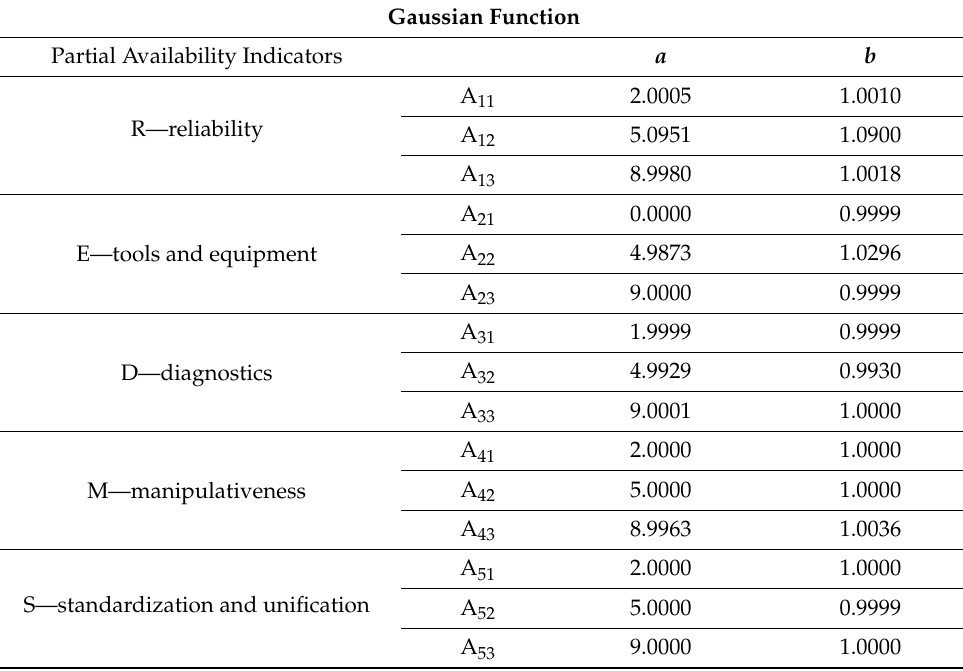
Table 4. Evaluation parameters of partial indicators for the Gaussian function.